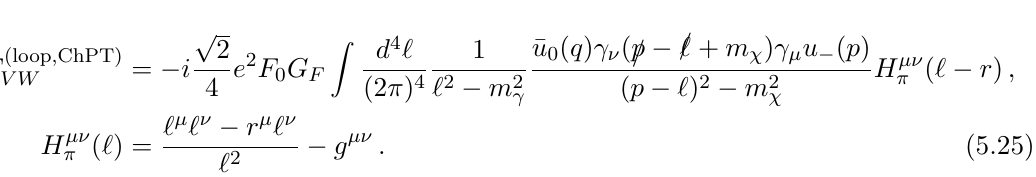
Figure 10 . The one-loop contribution to F V W in the Four-Fermi theory. The double line denotes ◦ the current correlator Γ µν . The points (cid:4) and are the separated vertices proportional to q 1 V A and q 2 ∗ ( x ) , W